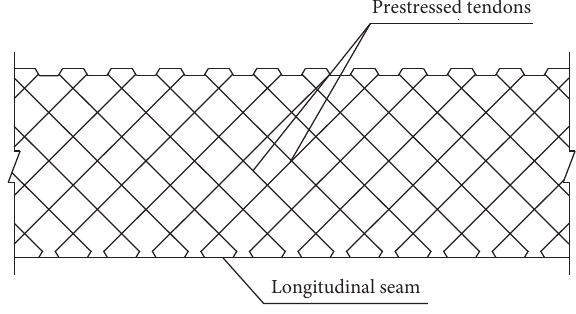
Figure 2: OPC schematic diagram.